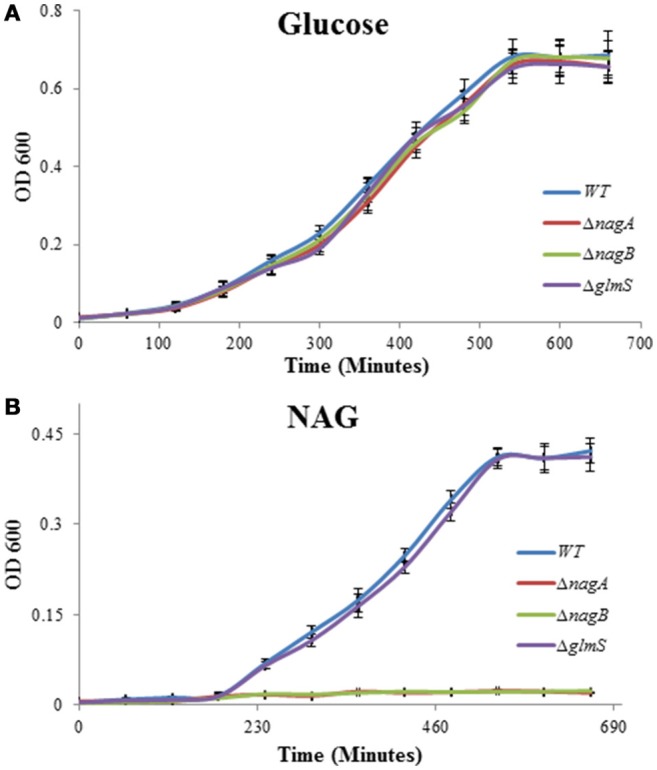
Growth of S. pneumoniae D39 wild-type and its isogenic mutants ΔnagA, ΔnagB, and ΔglmS grown in CDM with 0.5% glucose (A) and 0.5% NAG (B).